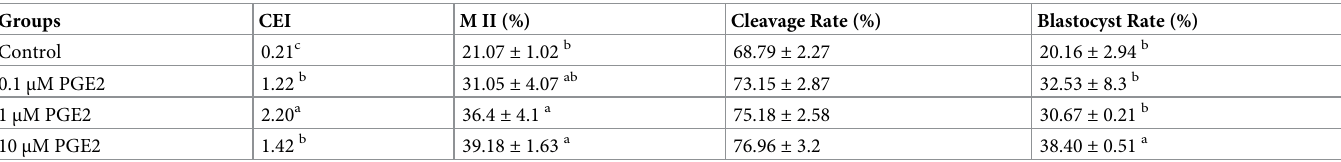
CEI: cumulus expansion index, M II (%): Percentage of oocytes at the M II stage. Cleavage and Blastocyst rates were assessed by in vitro fertilization in COCs. Different superscripts demonstrate significant differences (P < 0.05) within each column. 5 replicates and the minimum number of oocytes in each replicate were 50, 20 and 20 for assessment of development, MII rate, and CEI,